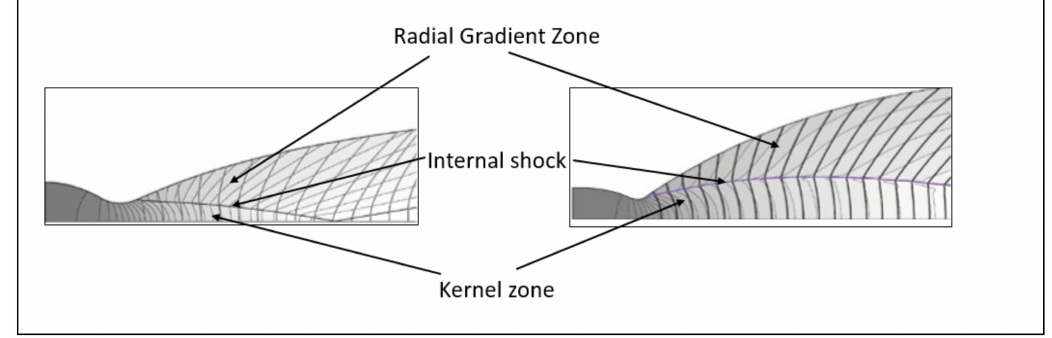
Figure 9. ( left ) Truncated idealised contoured (TIC) nozzle ( right ) and thrust-optimised contoured (TOC)